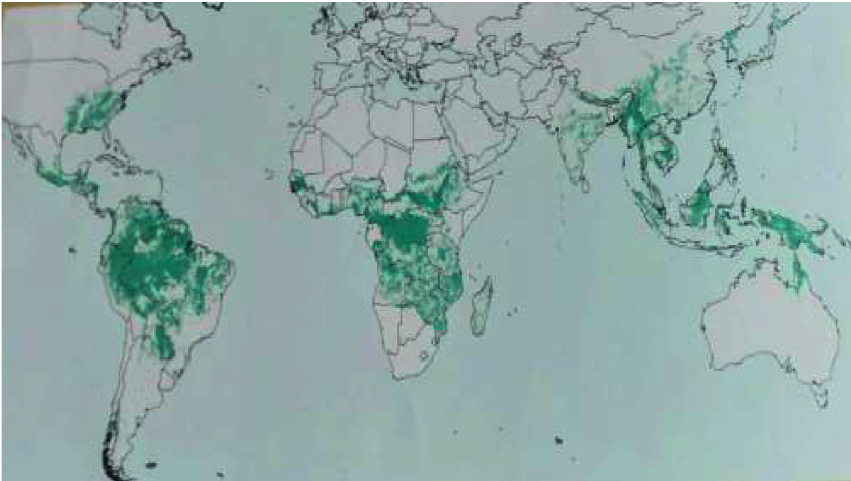
Figure 1: Global bamboo resource distribution among the four major geographic regions (source: